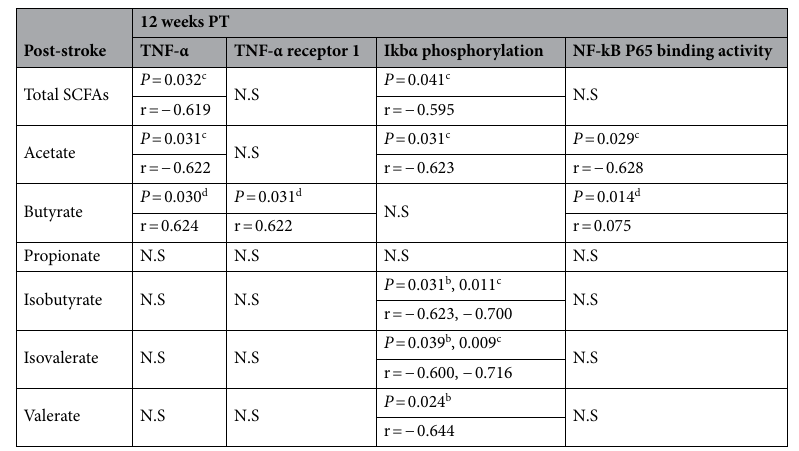
Table 1. Correlations between changes in fecal SCFAs levels post-stroke and jejunal inflammation at 12 weeks post-treatment in a pig model of ischemic stroke. Time point of fecal SCFAs showing significant correlation: a = Acute 1, b = Acute 2, c = Subacute, d = Chronic. r = Pearson correlation coefficient.